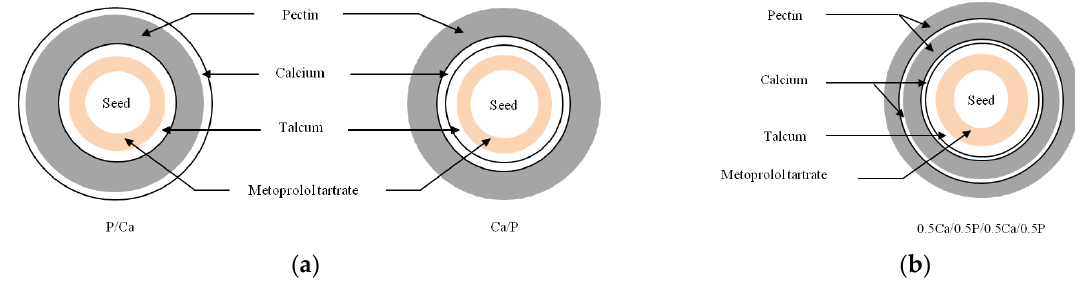
Figure 1. Illustration of alternate coated pellets with ( a ) coating sequence I, 2 - layer coating; ( b ) coating sequence II, 4 - layer coating based on the same coating quantity .